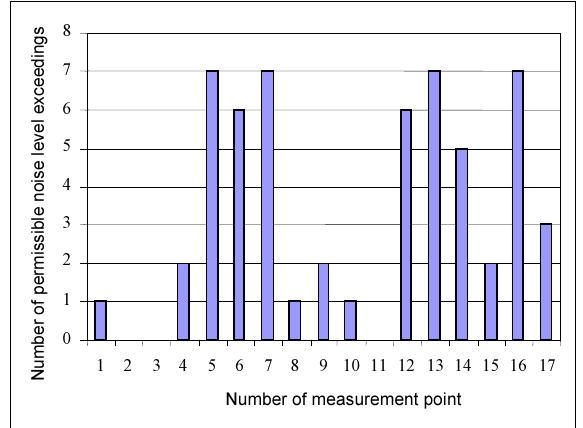
Fig. 2. Number of the excesses of permissible noise level in the